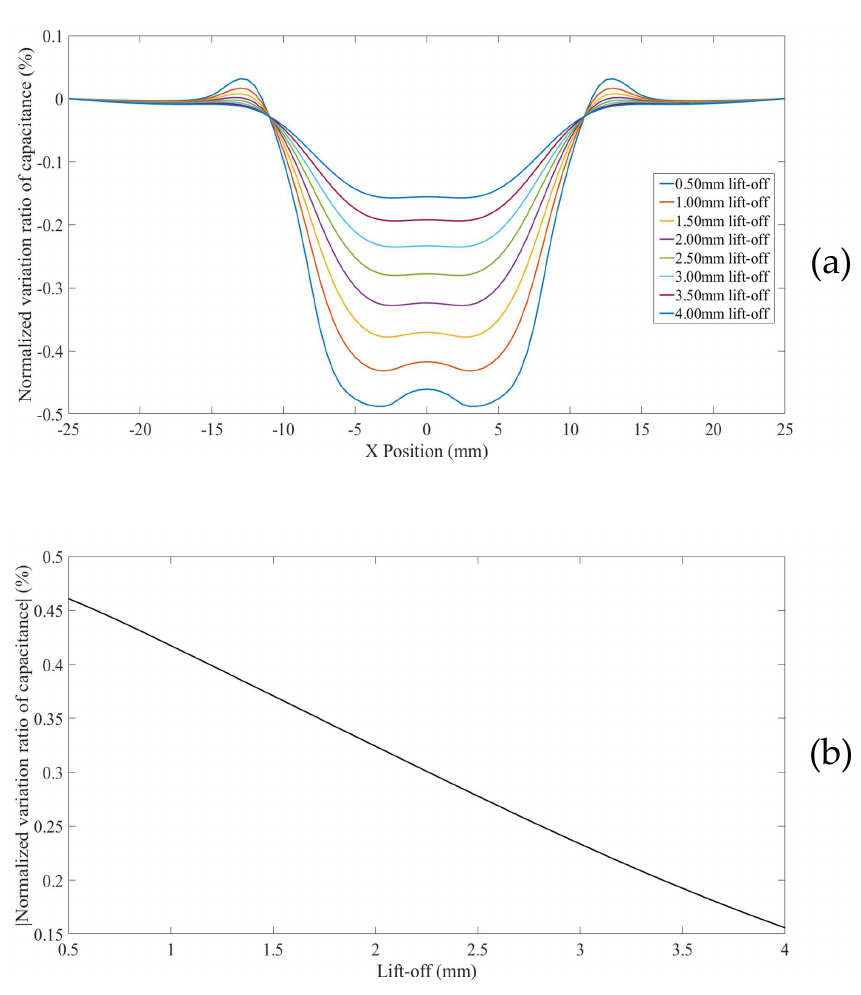
Figure 10. ( a ) NVR curves for Model 4 with lift-offs increased from 0.5 mm to 4 mm and ( b ) absolute values of the NVRs at the centre point against